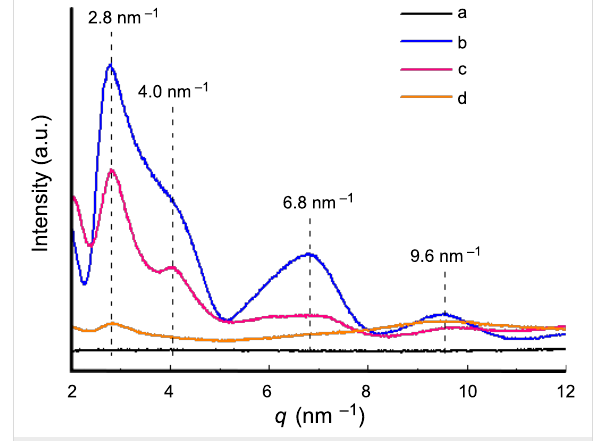
Figure 14: WAXD profiles of (a) quartz-glass capillary background, (b) bare imogolite, (c) BMPOPO 4 -imogolite, and (d) PMMA- g -imogolite with M n = 32700 and M w / M n = 1.33. Reprinted with permission from W. Ma et al., Chem. Commun. 2011, 47, 5813–5815 [40]. © 2011, The Royal Society of